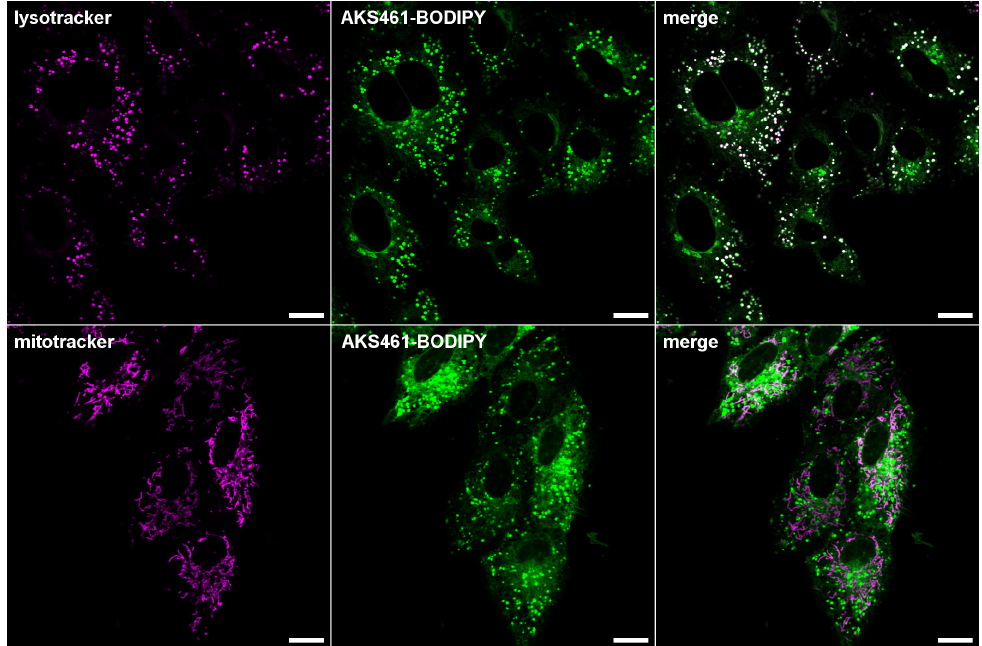
Figure 2. AKS461 is localized in the lysosome. Dual color live-cell visualization of AKS461 ( middle panel ) and lysosomes ( upper left panel ) or mitochondria ( lower left panel ). Vero cells were labeled with 50 nM LysoTracker Red DND-99 ( upper row magenta ) or 100 nM MitoTracker Deep Red ( lower row magenta ), and AKS461 clicked to DBCO-BODIPY ( green, middle panel ), respectively. Colocalization analysis using JACoP [34] showed a strong correlation between the signal of LysoTracker Red DND-99 and AKS461-BODIPY (Pearson coe ffi cient 0.70 ± 0.02) and only a moderate correlation between MitoTracker Deep Red and AKS461-BODIPY (Pearson coe ffi cient 0.47 ± 0.00). Scale bar 15 µm.